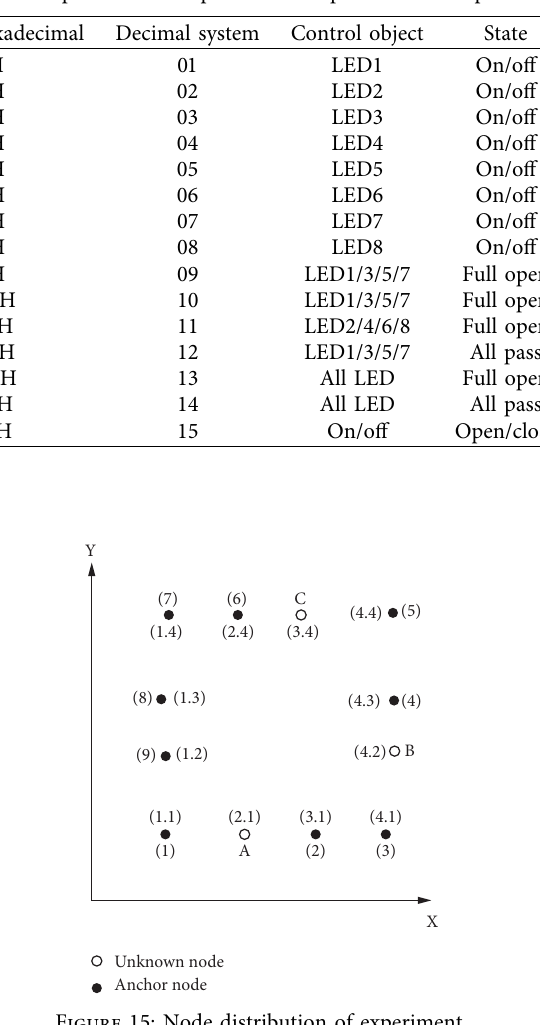
Table 5: Specific control protocol of experimental test platform.